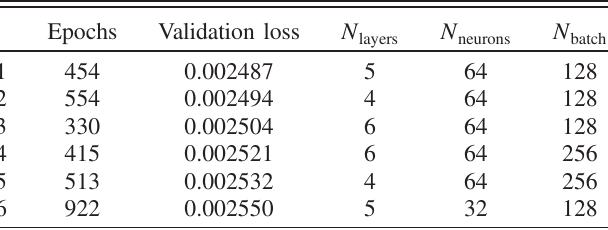
TABLE IV. A comparison of hyperparameters (only the six best combinations). The training is stopped if there is no improvement in the validation loss for 100 epochs.